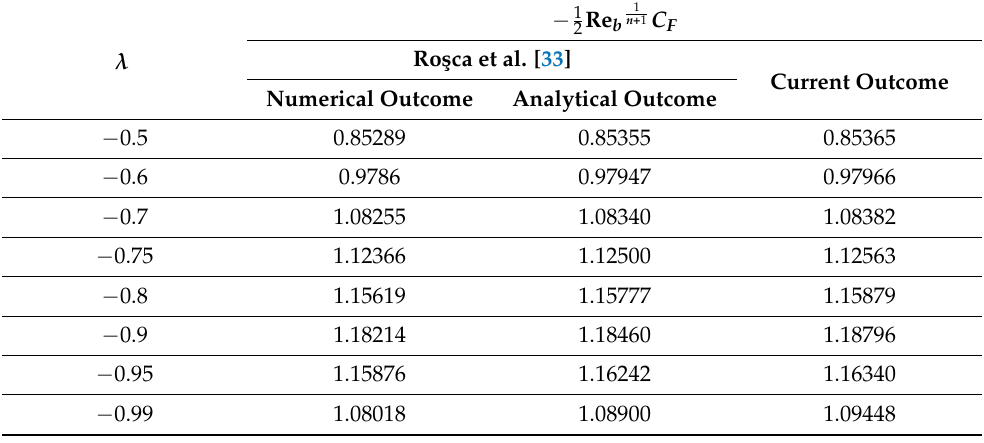
Table 3. Comparison of the skin friction coefficient results of Ro¸sca et al. [33].